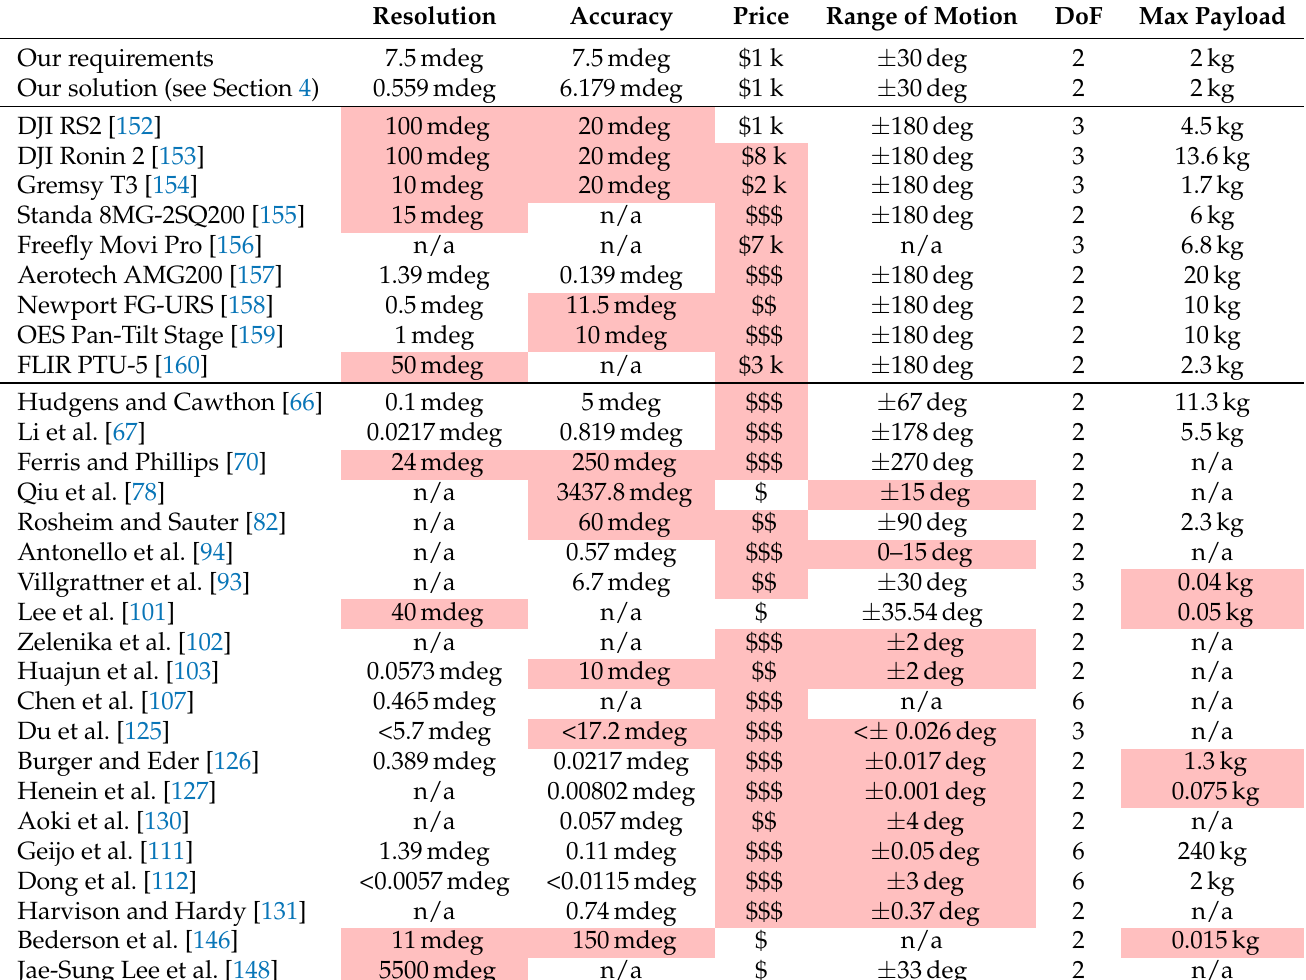
Table 1. Overview of existing gimbal mechanisms from commercial suppliers and research. The indi- vidual specifications are compared with our requirements to highlight that no system can fulfill them within the specified price range. For many mechanisms, exact manufacturing costs are not known. Based on the depicted components, a rough price range is estimated as $–$$$. Most systems have different ranges of motion per axis. As pan is the most relevant axis to us, in those cases, only the pan range of motion is